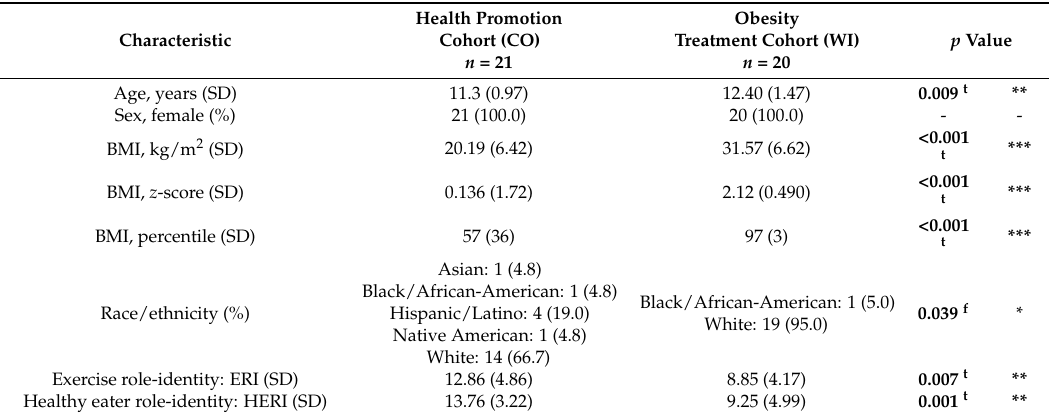
Table 2. Health identity variables at baseline, post-camp, and follow-up. Data are listed by camp.